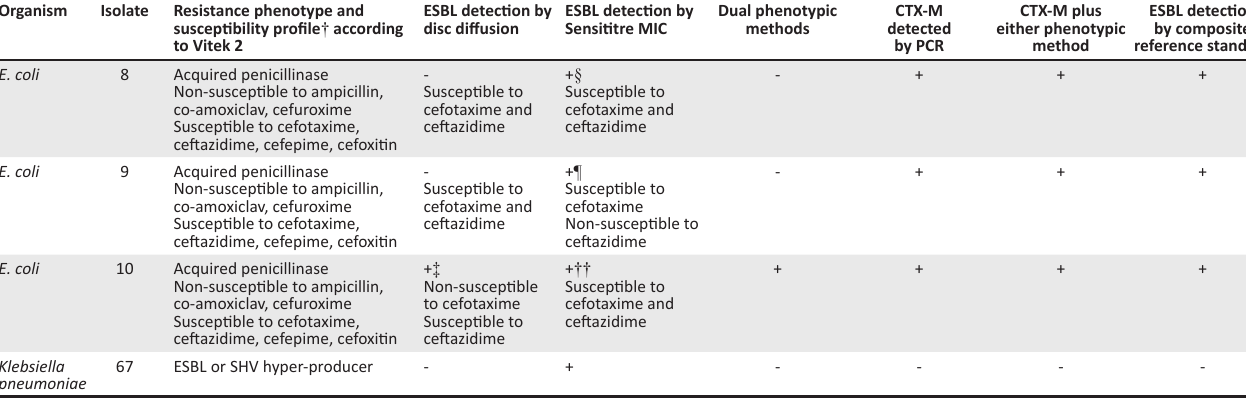
Table 1-A1: Analysis of discrepant results for extended-spectrum beta-lactamase detection.